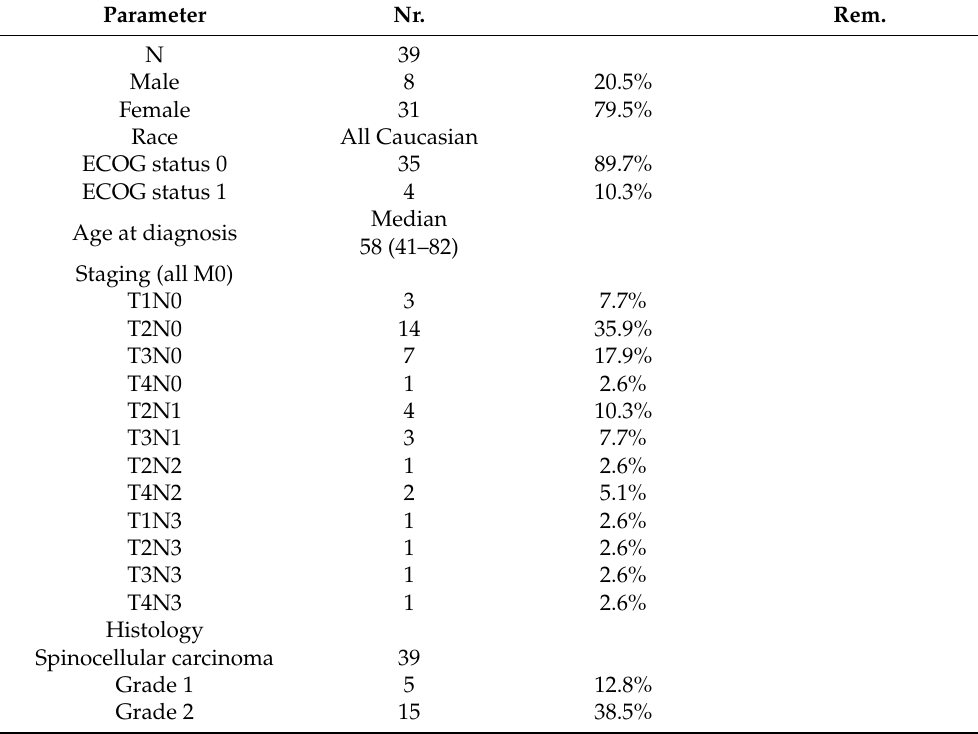
Table 1. Patient